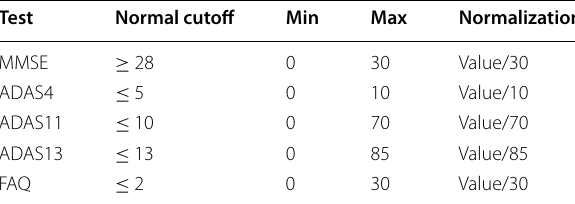
Table 2 Test score cutoffs and normalizations Test